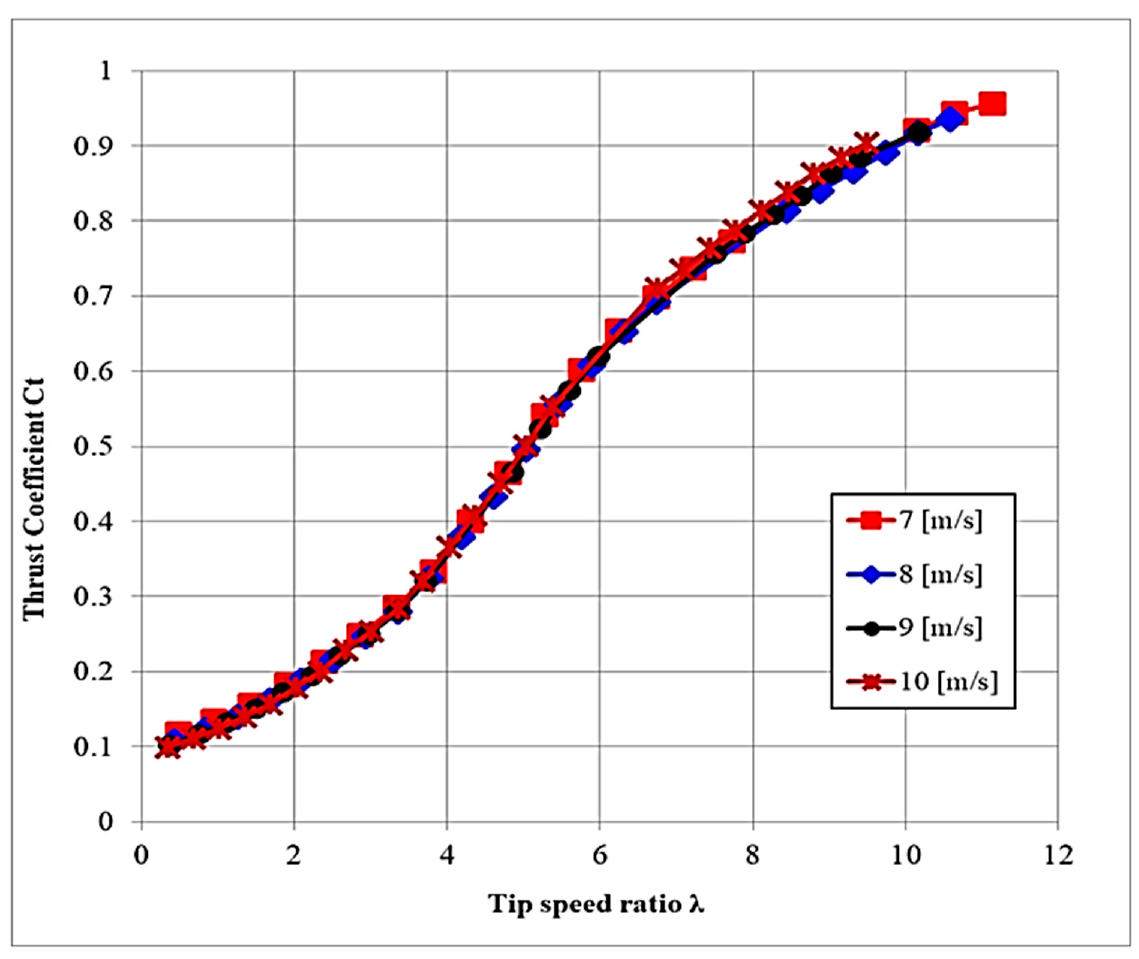
Figure 6. The thrust coefficient changes under different wind speeds 7, 8, 9 and 10 m/s. The thrust coefficient C T increases monotonically when the tip speed ratio λ increases at any wind speed as exhibited in Figure 6. The thrust coefficient value is C T = 0.76 at the optimum tip speed ratio of λ = 7.43 and the wind speed of U = 10 m/s. There is almost no difference in the thrust coefficient with the different wind speeds. The thrust force is generated by the lift force on the blade elements of the rotor blades. The lift coefficient depends on the angle of attack of the blade element. Therefore, the angle of attack is similar at the same tip speed ratio, and it does not depend on the mainstream wind speed. In addition, the Avistar airfoil used for this experiment did not depend on the low Reynolds number. The Reynolds number in the wind tunnel is within the range presented in Section